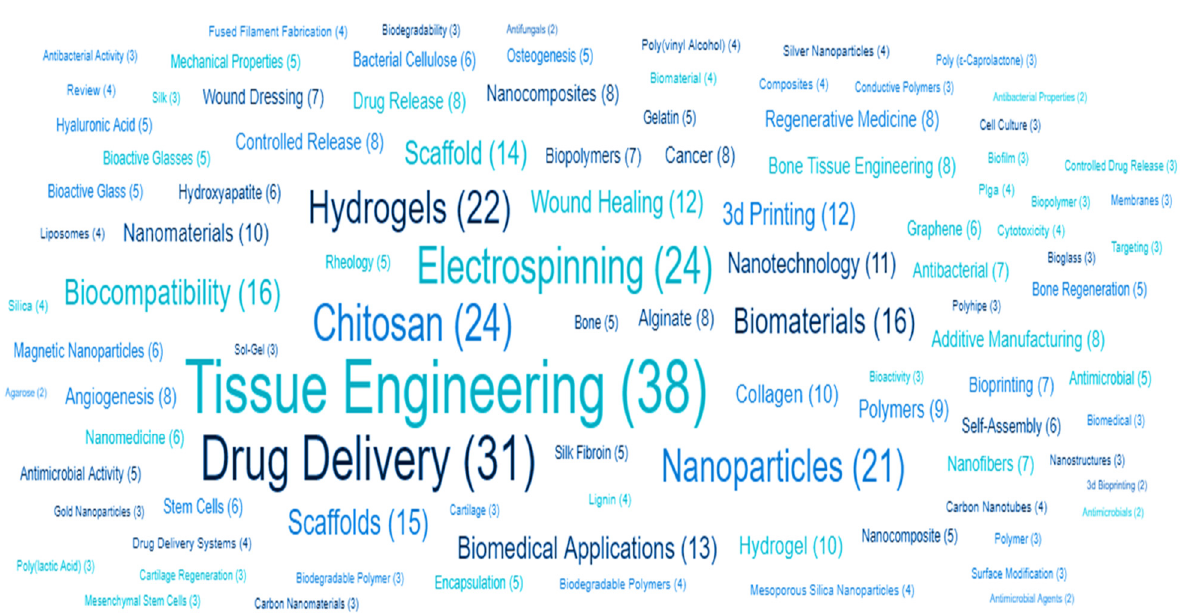
Figure 1. Infographic word-cloud visualization of the semantic clustering network of the keywords for physicomechanical, thermostability, and in vitro drug release studies of bioactive/biodegradable polymeric materials with remarkable biocompatibility in biomedical research.